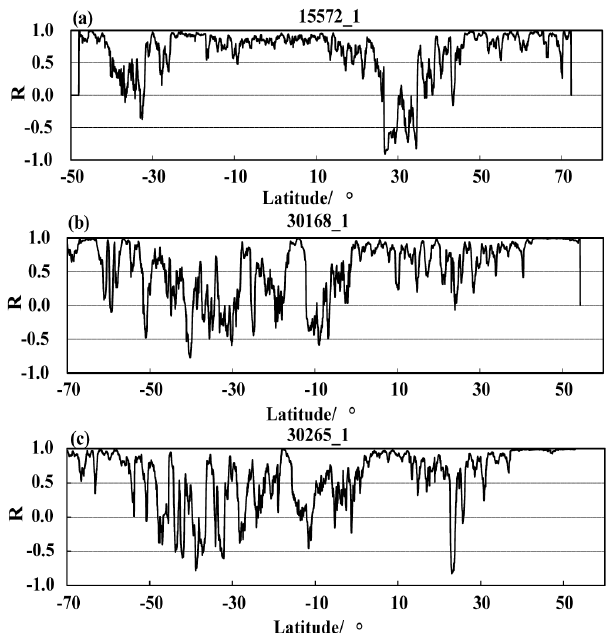
Figure 6. The correlation coefficients of N e and T e along the three